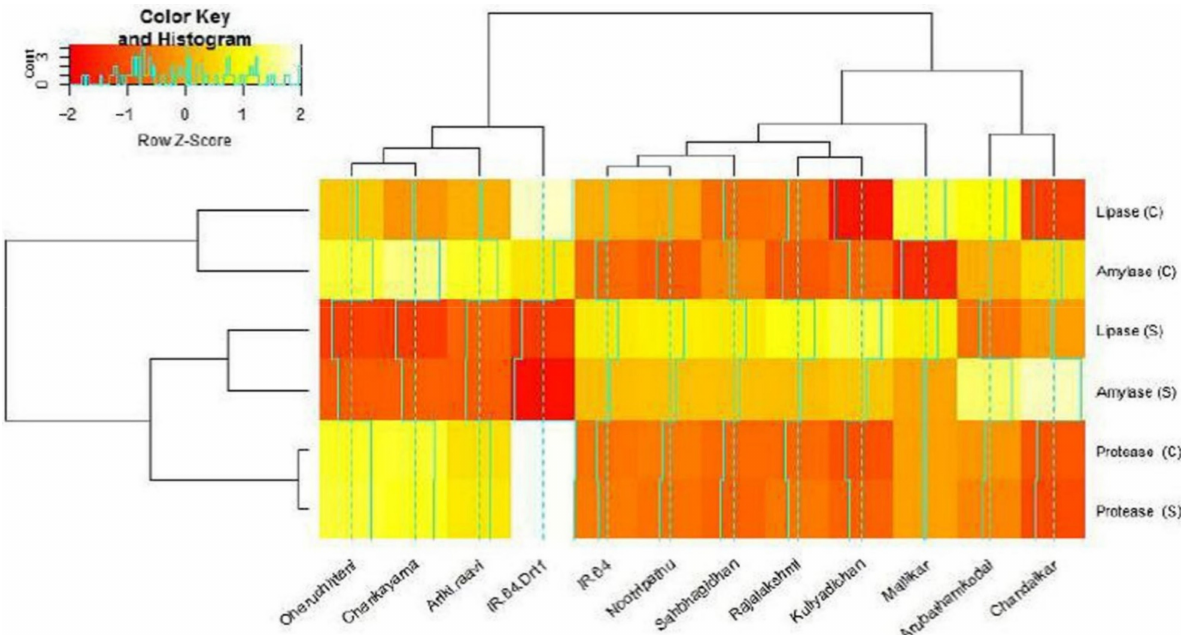
Figure 3. Heatmap and clustering of selected rice genotypes based on hydrolytic enzyme activ- ities, such as α -amylases, proteases and lipases. NS—non-stressed environment; C—controlled